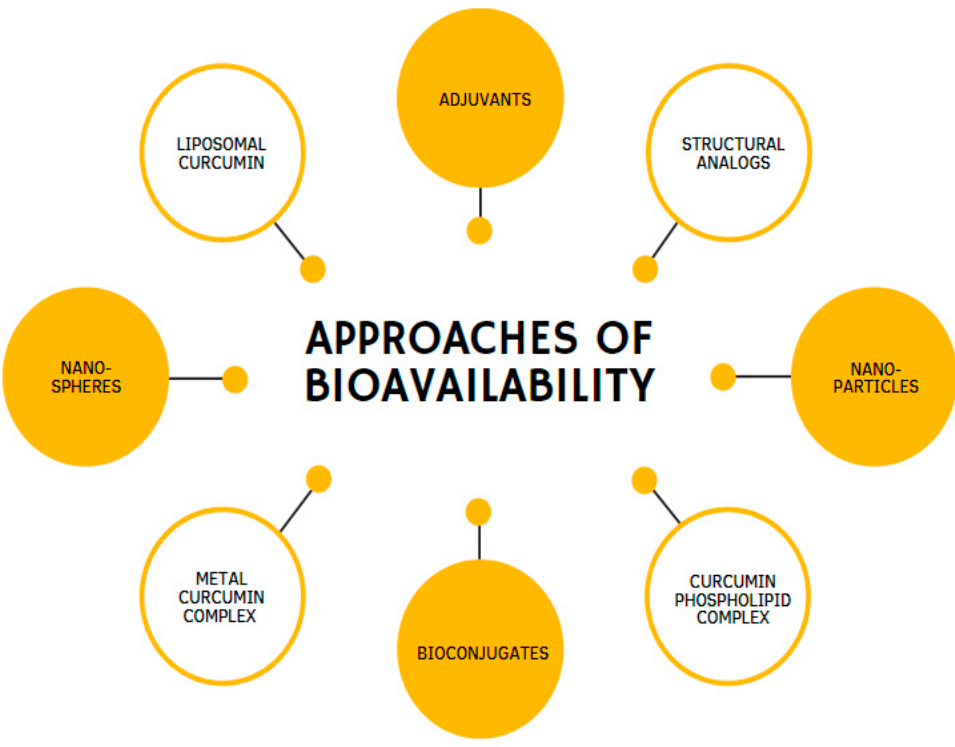
Figure 4. Different methodologies are used to enhance the bioavailability of curcumin.